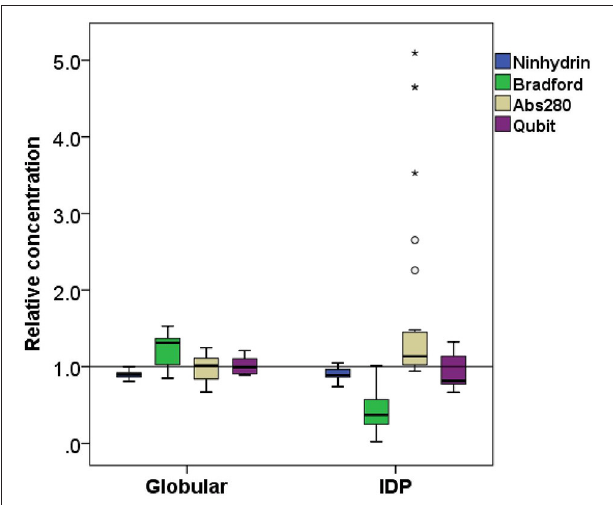
FIGURE 3 | Comparison of relative concentration measurements of folded and disordered proteins. Box plots of the relative concentration of globular and disordered proteins measured by the four methods ninhydrin, Bradford, Abs280, and Qubit.